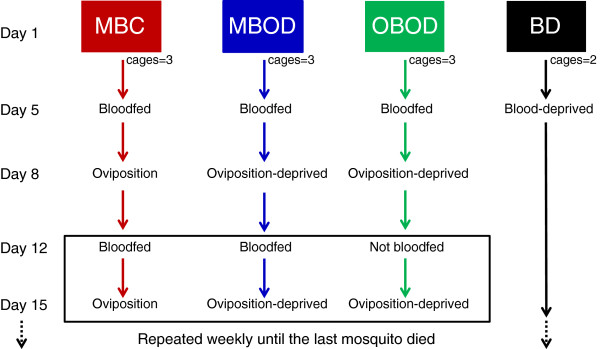
Diagram of the experimental design used in this study. Treatments are abbreviated as follows: multiple-bloodfed non-oviposition-deprived control group (MBC; red), multiple-bloodfed oviposition-deprived (MBOD; blue), once-bloodfed oviposition-deprived (OBOD; green), and blood-deprived age control (BD; black). 150 newly-emerged females were placed in each cage at the start of the experiment. The boxed area and dotted arrows indicate that these steps were repeated weekly until the last mosquito in the experiment died.